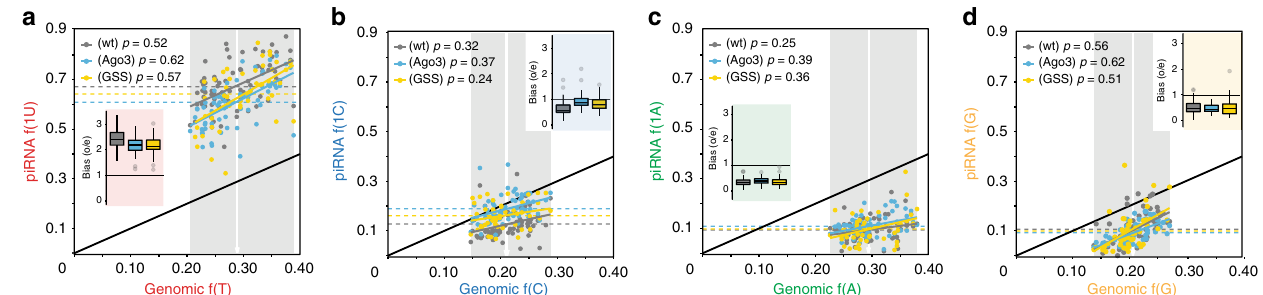
Fig. 4 The 1U-bias of Piwi-piRNAs is established by a general mechanism that restricts all nucleotides but U in the fi rst position. Piwi-piRNAs from OSC are grouped by piRNA generating clusters. The observed a 1U, b 1C, c 1A, and d 1G piRNAs ( y -axis: piRNA f(1×)) are correlated with the expected genomic nucleotide frequencies ( x -axis: genomic f(x)) of their generating cluster. Inserts represent the corresponding nucleotide bias (observed/expected nucleotide frequencies) as box plots with the median indicated as center line with the upper and lower quartile represented by the box. PiRNAs that are associated with FH-Piwi(wt) (gray) and two FH-Piwi-SL mutants, (Ago3) (blue) and (GSS) (yellow), are shown as median of three biological replicates ( n = 3). [ M = 1: unique mapping reads are considered]. (See also Supplementary Fig. 4 and Supplementary Data 6.)